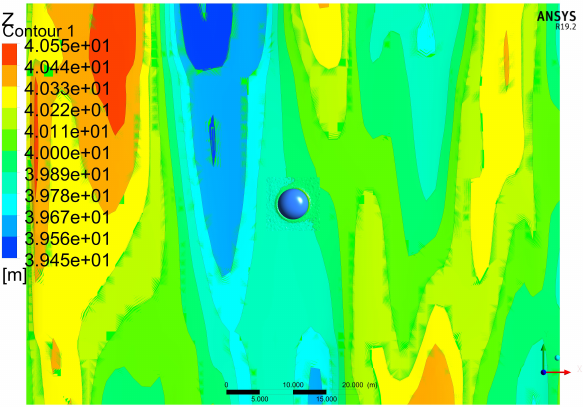
Figure 11. Wave pattern on the free surface at t = 0.5 s.